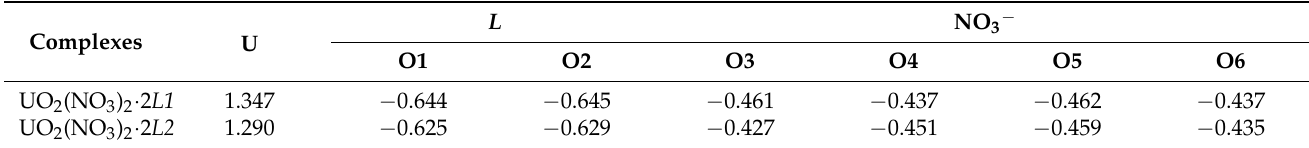
Table 4. NPA charges on the Uranium and Oxygen atoms in UO 2 (NO 3 ) 2 · 2 L species. Complexes